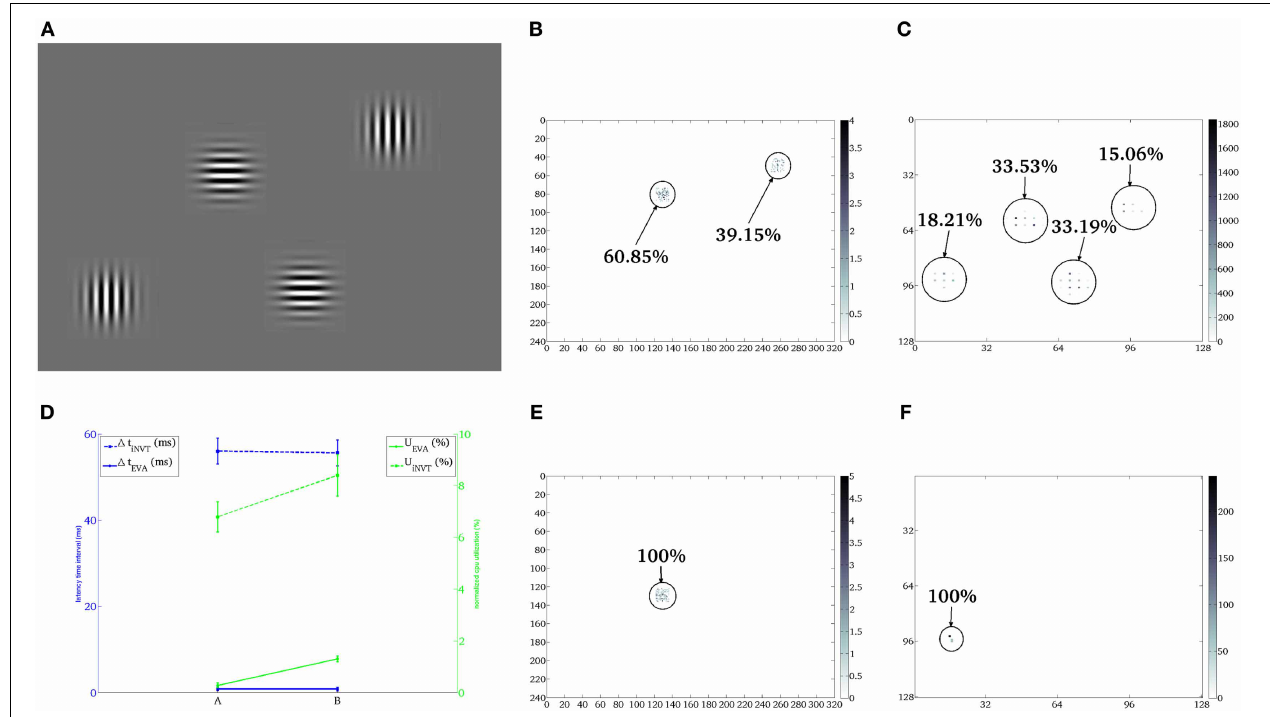
FIGURE 3 | First scenario. Case A: comparison of the shifts generated by iNVT (B) and EVA (C) in response to four oriented gratings (A) under bright background illumination ( ∼ 55.6 LUX—indoor illumination of a diffuse bright natural light). Case B: comparison of the shifts generated by iNVT (E) and EVA (F) under dim background illumination ( ∼ 2.7 LUX—dim illumination that typically would require